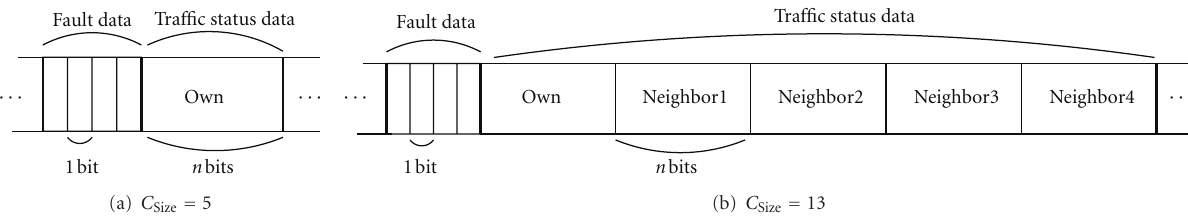
Figure 5: Structure of monitoring packet payload with cluster sizes 5 and 13. n is the number of bits required to represent a tra ffi c status value with a certain